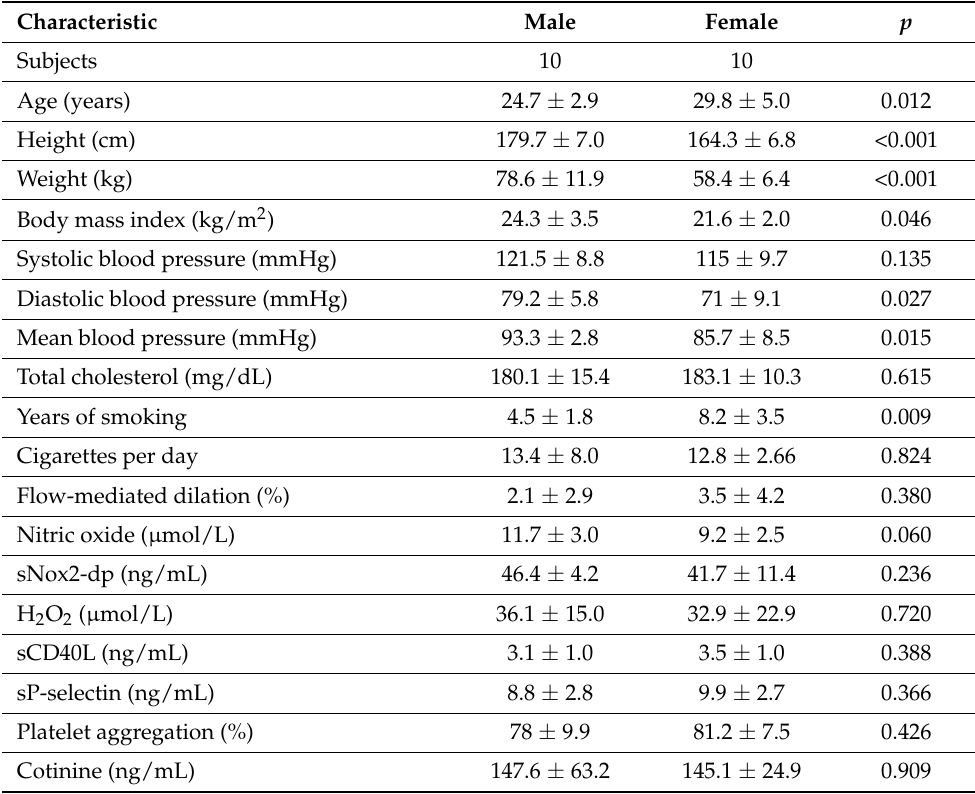
Table 3. Chronic users of traditional combustion cigarettes.